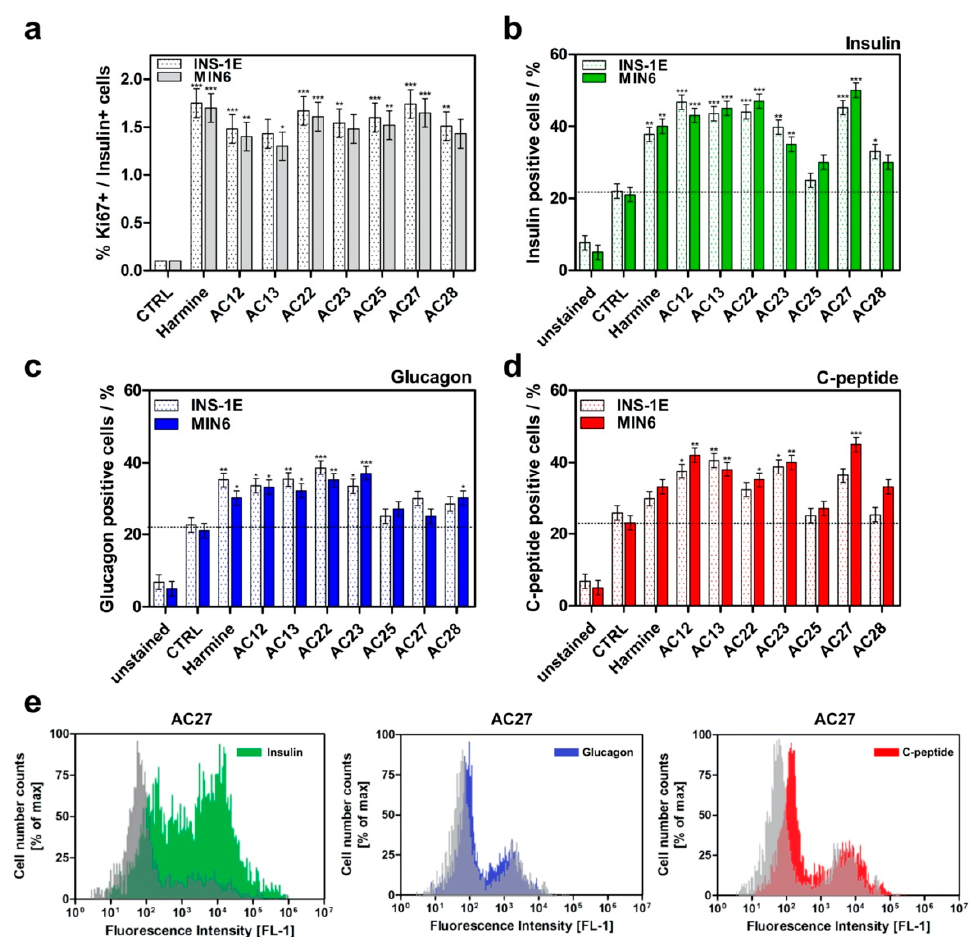
Figure 7. The influence of DYRK1A inhibitors on INS-1E and MIN6 function: Flow cytometry analysis of insulin, C-peptide and glucagon expression in MIN6 and INS-1E cell lines. 24 h after incubation with 5 µ M of the inhibitors and 72 h after applying the compounds, the cells were stained with the appropriate antibodies. ( a ). Effects of inhibitors on Ki67 immunolabeling in MIN6 and INS-1E cell lines. ( b ) Effects of inhibitors on insulin immunostaining in MIN6 and INS-1E cell lines. ( c ) Effects of inhibitors on C-peptide immunostaining in MIN6 and INS-1E cell lines. ( d ) Effects of inhibitors on glucagon immunostaining in MIN6 and INS-1E cell lines. ( e ) Insulin, Glucagon and C-peptide level in INS-1E cells treated with AC27 compared with control (grey). Data are expressed as mean ± SEM. * p < 0.05, ** p < 0.01; *** p < 0.001 as compared to the control.